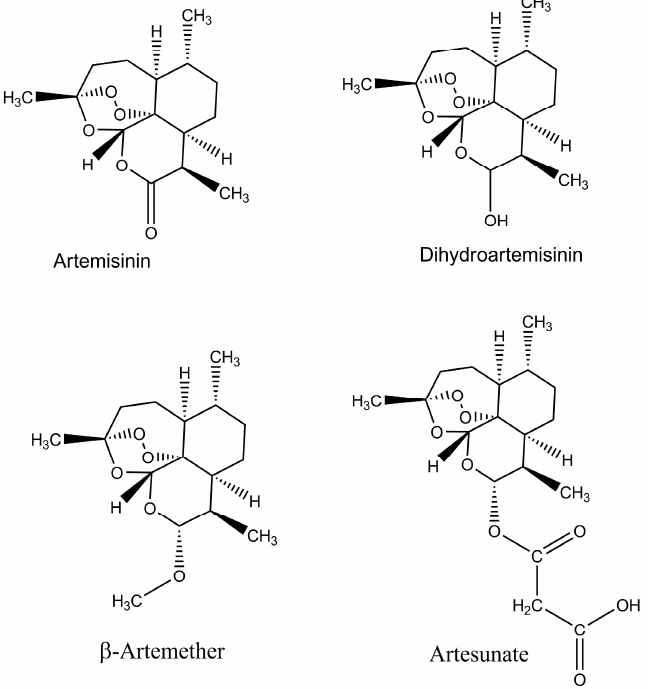
Figure 1. Chemical structure of artemisinin and its derivatives.